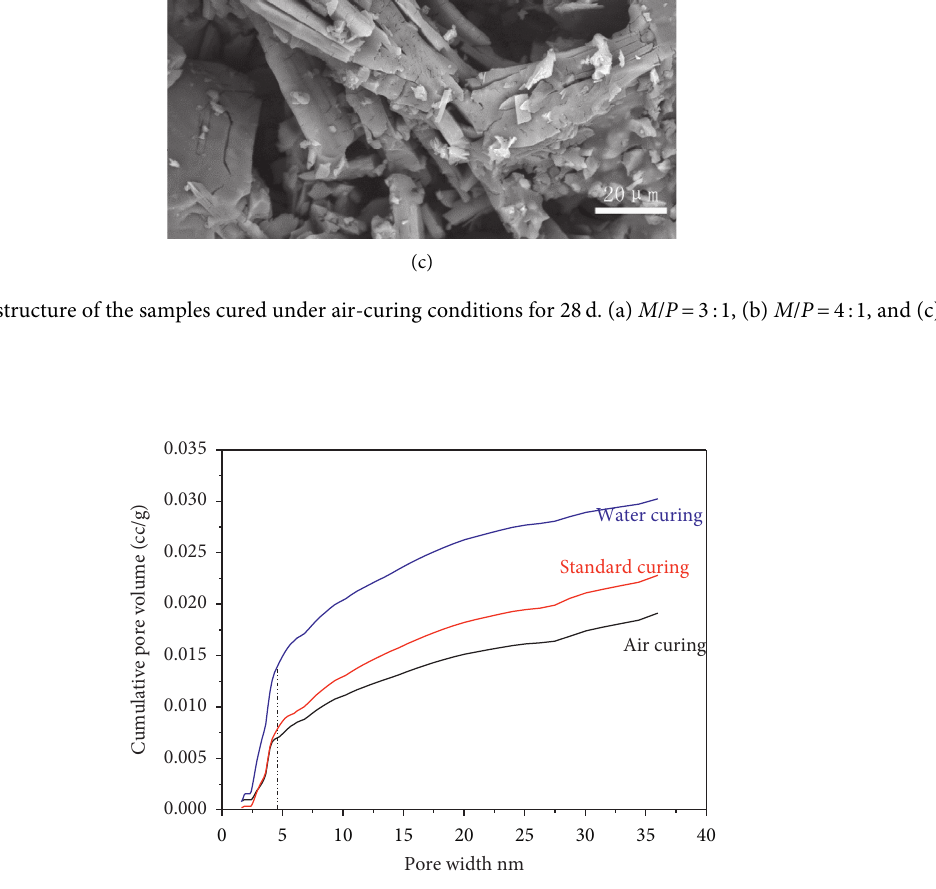
Figure 14: Cumulative pore volume curves of MPC with the M / P ratio of 3:1 cured under three curing conditions for